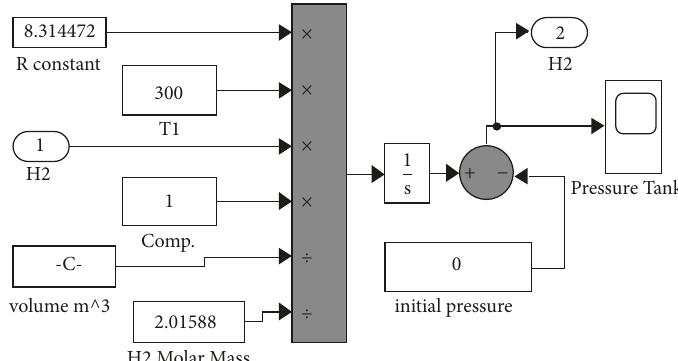
Figure 9: Hydrogen tank in MATLAB/Simulink [12, 13].